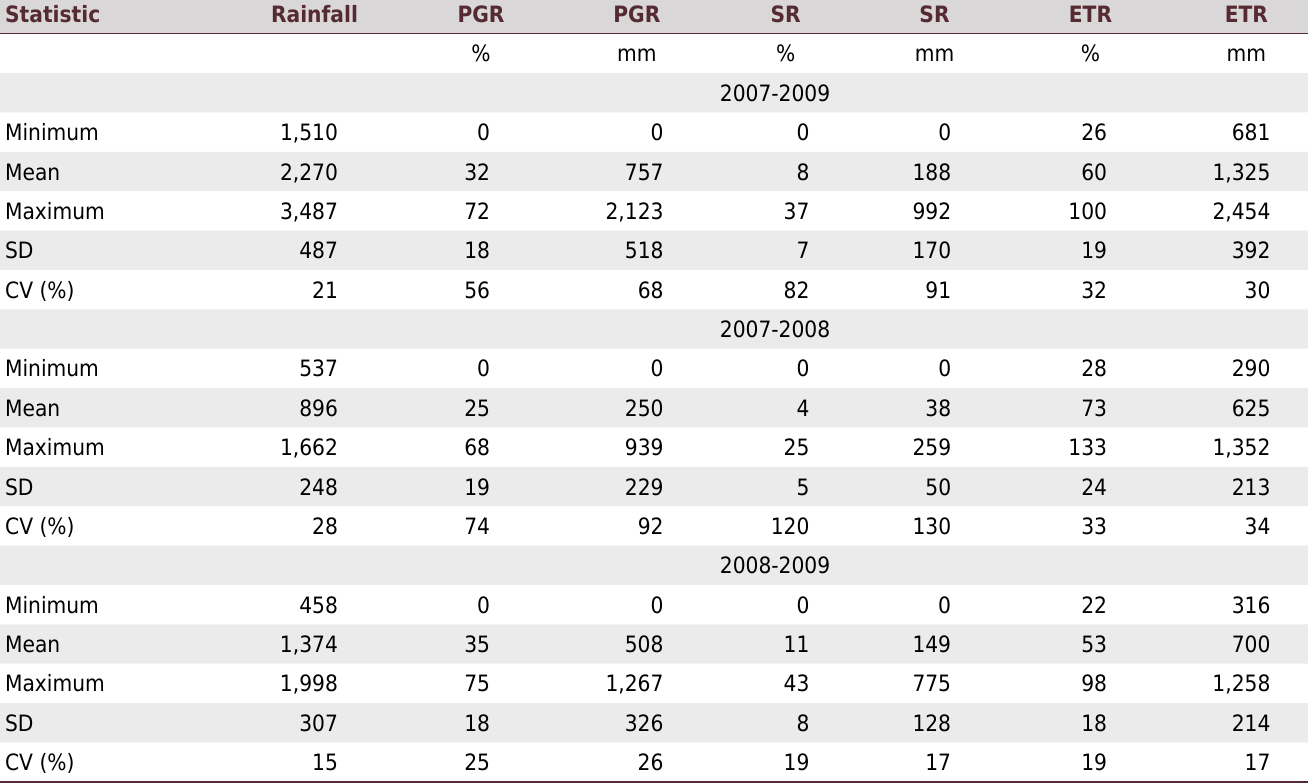
Table 3. Statistical summary of the water balance for the two-year period (2007-2009) and the hydrological years 2007-2008 and 2008-2009 in the Doce River Basin, obtained with the BALSEQ model for the point data estimates Statistic